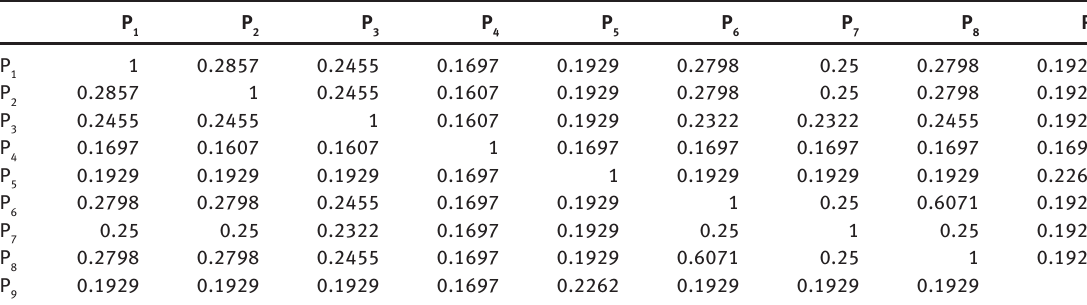
Table 7: Classification of Patients: Fuzzy Equivalence Relation Obtained Using Gower’s Coefficient Method (Case Study: Nine Patients, Nine